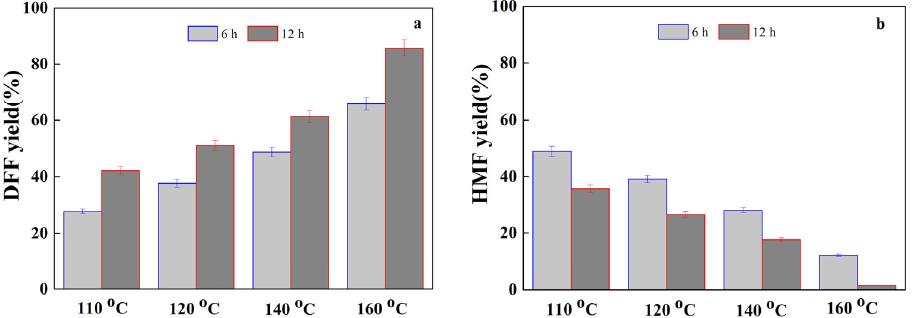
Figure 10. DFF yield ( a ) and HMF yield ( b ) as a function of reaction temperature under the catalysis of Amberlyst 15 and Cu-K-OMS-2-II.